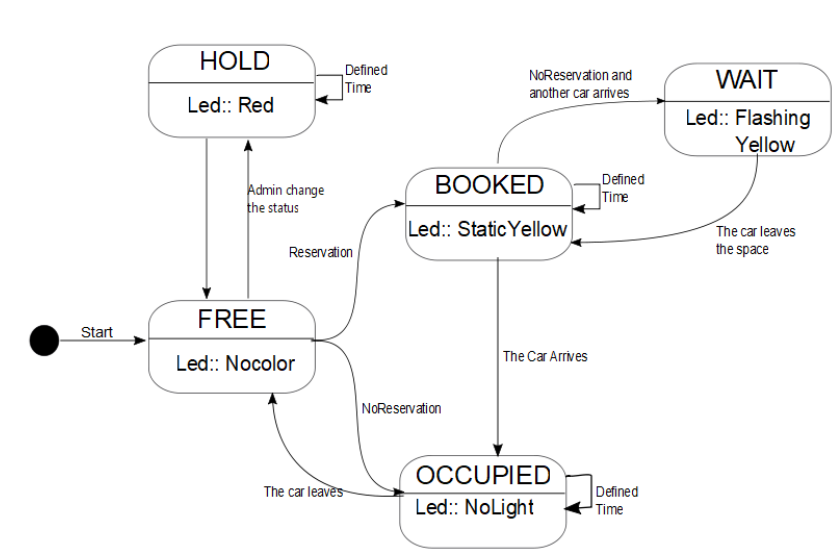
Figure 3. State diagram of the SPIN-V sensor at parking